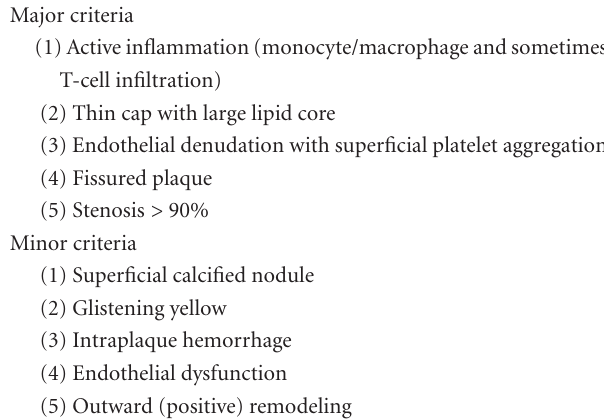
Table 1: Criteria for defining vulnerable plaques